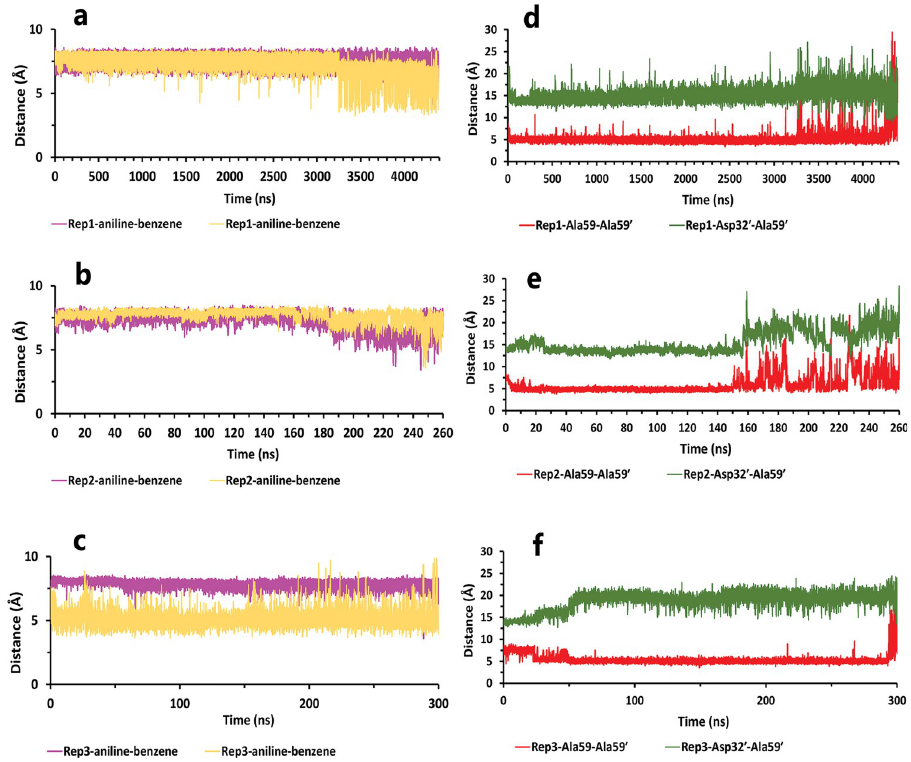
Fig 5. The details of distances between particular parts of compound 10 complexed with HTLV-1 protease when Asp32 of chain A was protonated in three replicas. A , B , and C , The distance between COMs of both aniline rings and benzene rings, which were in a position that could form pi-pi intramolecular interactions in all replicas. These plots prove that these fragments were so close together during the simulation. D , E , and F , The distance between COMs of Ala59 and Ala59 0 , and also Asp32 0 and Ala59 0 in all replicas (these plots should be checked along with Fig 3).